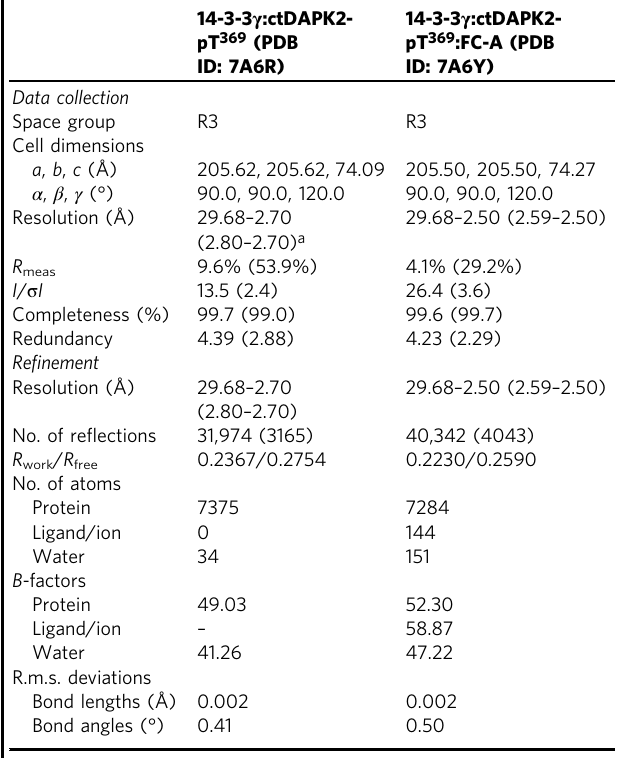
Table 1 Data collection and re fi nement